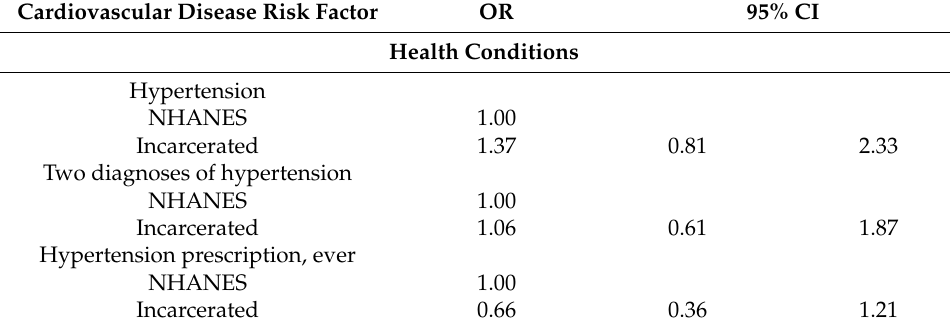
Table 4. Association between incarceration status (individuals incarcerated at Coconino County Detention Facility compared to NHANES participants) and cardiovascular disease risk factors, 2017–2018 (N = 393). Cardiovascular Disease Risk